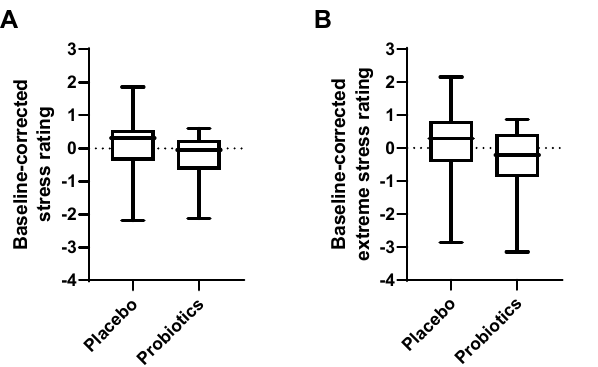
Figure 5. Effect of probiotic intervention on Actigraphy stress measurements. ( A ) Baseline-corrected average of daily stress ratings and ( B ) extreme daily stress ratings. Line presents median, box presents 25th and 75th percentile, whiskers present minimum and maximum.